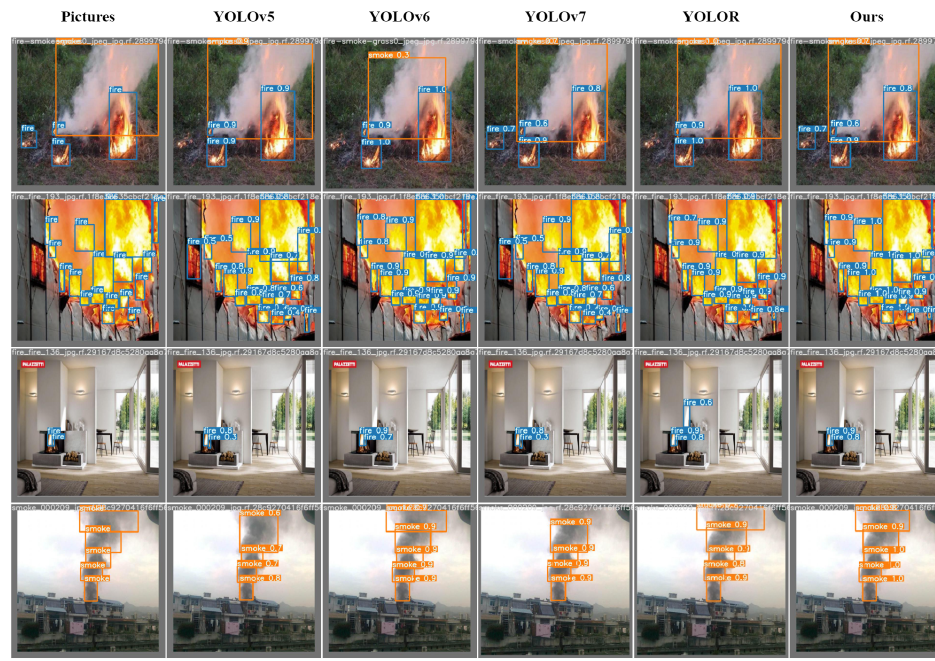
Figure 10. Comparison of results with standard one-stage object